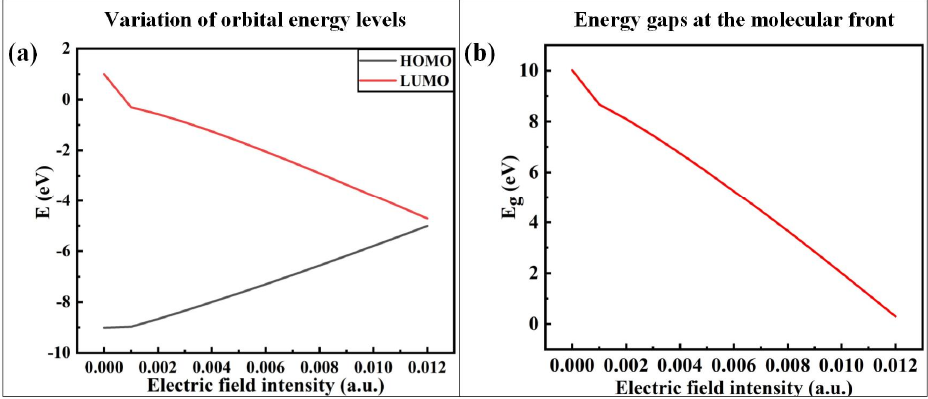
Figure 8. Variation in orbital energy levels and energy gaps at the molecular front at different electric field intensities.